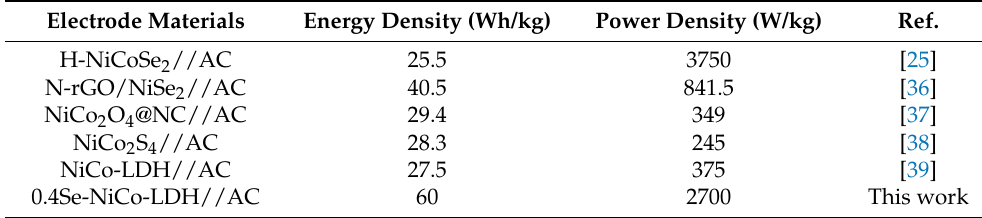
Table 1. Comparison of energy density and power density of 0.4Se-NiCo-LDH device with previ- ous